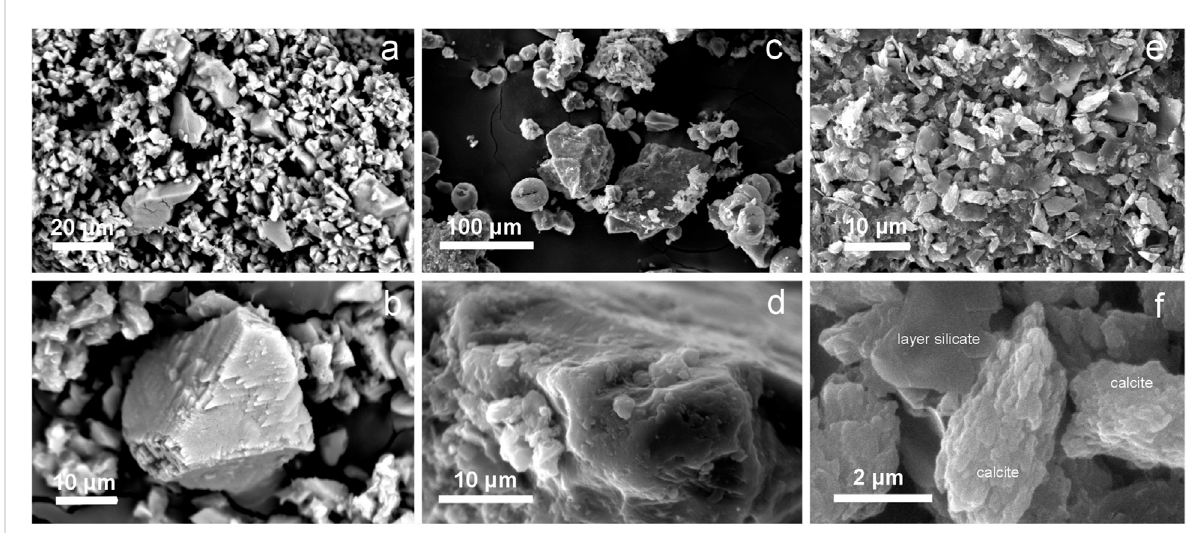
FIGURE 6 Secondary electron SEM images of typical mineral particles fi ltered from stream, rain and lakewater. (Note the different length scales of the images.) (A) Tributary-originated mineral grains with various sizes (small particles are calcite and clay minerals, large ones are quartz crystals). (B) A weathered calcite particle from Lovasi Séd stream. (C) Large quartz grains, pollen and unidenti fi ed mineral particles from a rainwater sample. (D) A characteristic quartz particle with an eroded surface from a Saharan dust sample; (E – F) Mg-bearing calcite particles that precipitated from lakewaterand allochtonouslayersilicatesfromalakewatersample;themorphologiesandsizesofaggregate-looking,elongated Mg-bearing calcite crystals are typical for particles precipitated from Lake